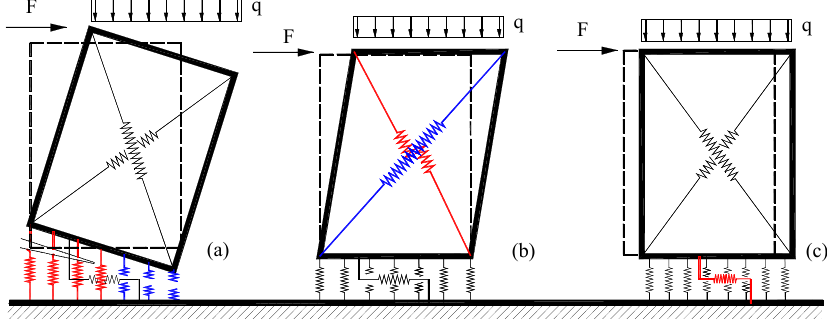
Figure 7. Main in-plane masonry failure mechanisms: ( a ) flexural; ( b ) shear-diagonal; and ( c ) shear-sliding.